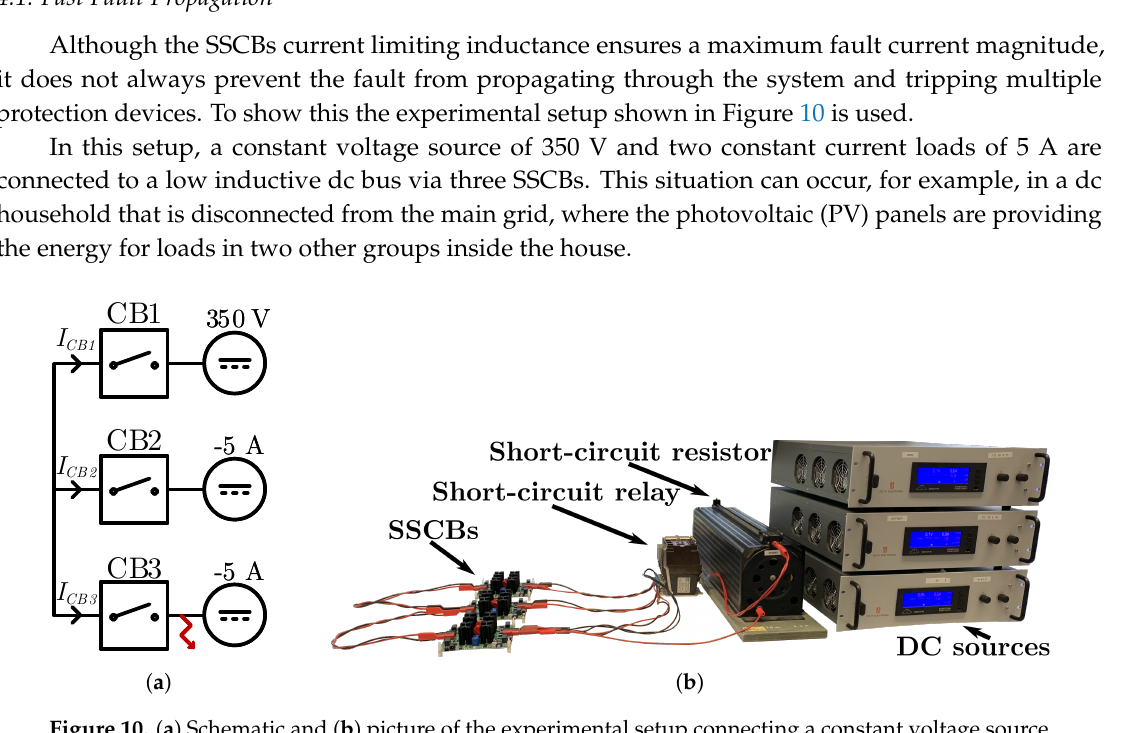
Figure 10. ( a ) Schematic and ( b ) picture of the experimental setup connecting a constant voltage source to two constant current loads through three